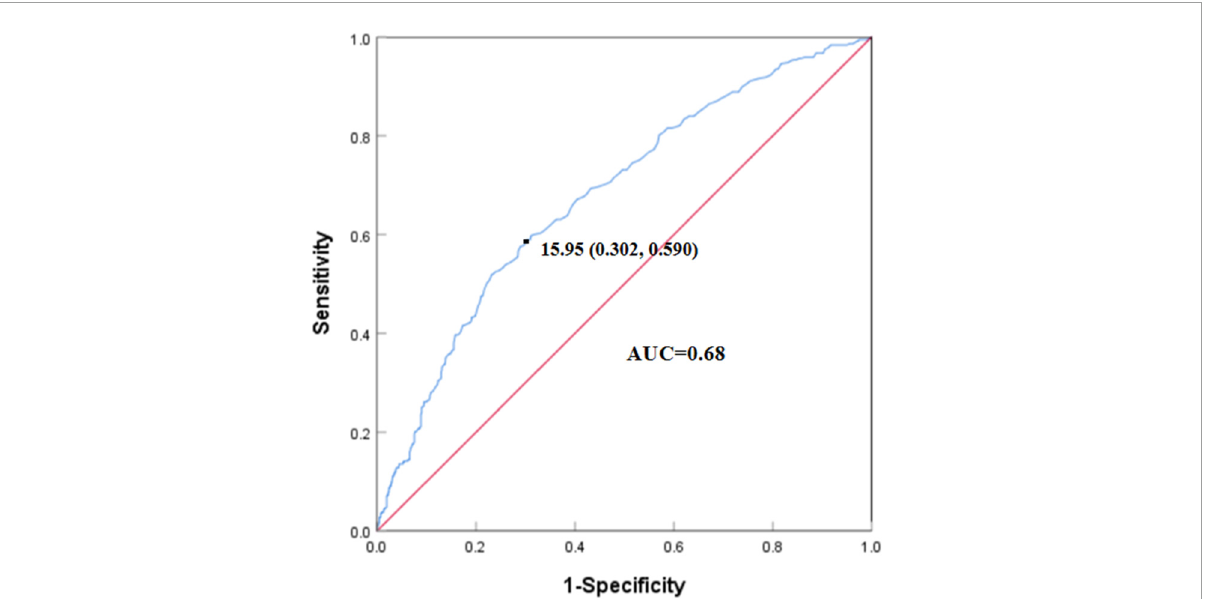
FIGURE3 Receiver operating characteristic (ROC) curve of serum tHcy levels for cognitive impairment. The optimal cut-off point of serum tHcy levels of patients with cognitive impairment was 15.95 µ mol/L. The specificity was 0.698 (1–0.302) and sensitivity was 0.590. The area under the curve (AUC) was